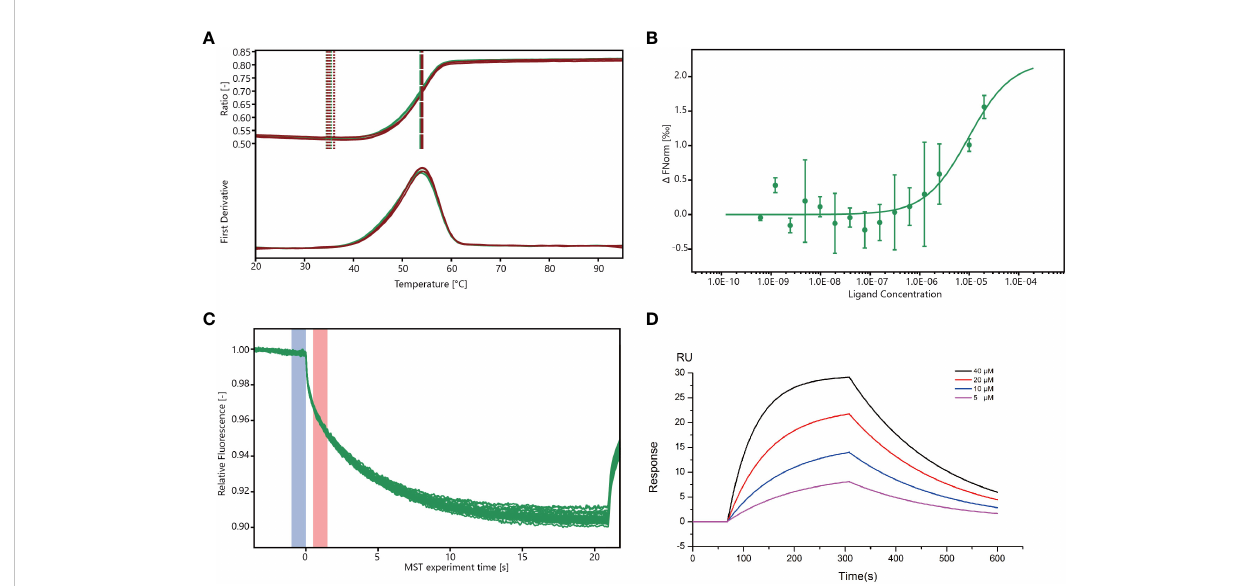
FIGURE 5 Wogonin blocks Mpro to disrupt PEDV infection. (A) Stability of Mpro determined by DSF assay. For the DSF assay, 1 mg/mL Mpro and 40 mM wogonin were employed. (B, C) Binding of Mpro to wogonin was investigated by MST assay. For MST assay, 40µM – 1.22 nM wogonin and 200 nM Mpro were employed. (D) Binding curve of wogonin with Mpro in surface plasmon resonance (SPR)